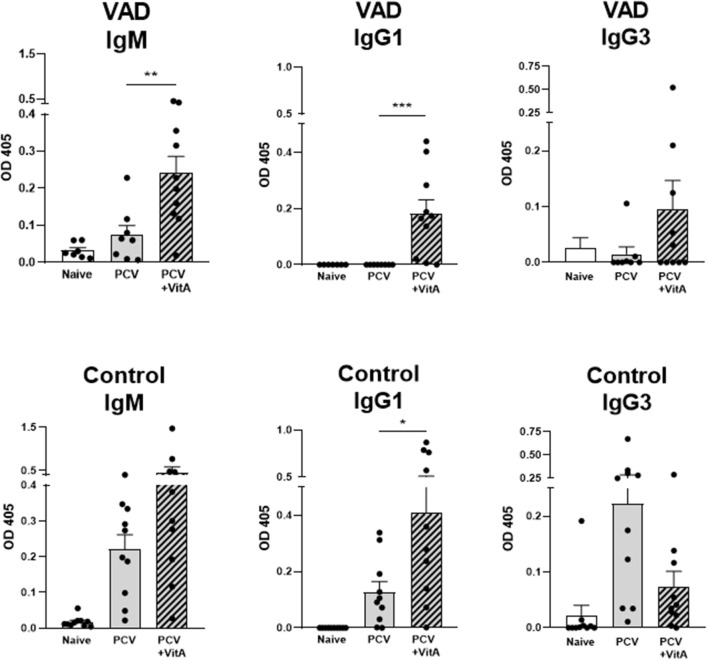
VAS and T4 polysaccharide-specific immune responses. Results from T4 ELISAs are shown for VAD (top row) and vitamin A-replete control (bottom row) mice. Separate ELISAs were conducted to measure T4-specific IgM IgG1, and IgG3 antibodies. Statistical comparisons were made using Mann Whitney tests and GraphPad Prism software (*p < 0.05, **p < 0.01, ***p < 0.001). IgM levels (for VAD mice), and IgG1 levels (for VAD and control mice), but not IgG3 levels, were significantly improved with VAS.